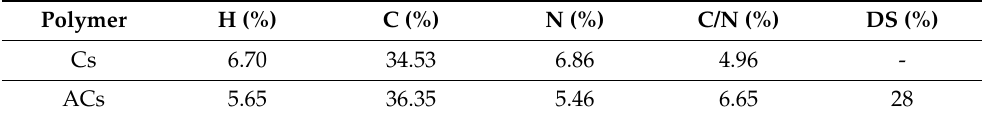
Table 1. DS and the elemental analysis data of Cs and